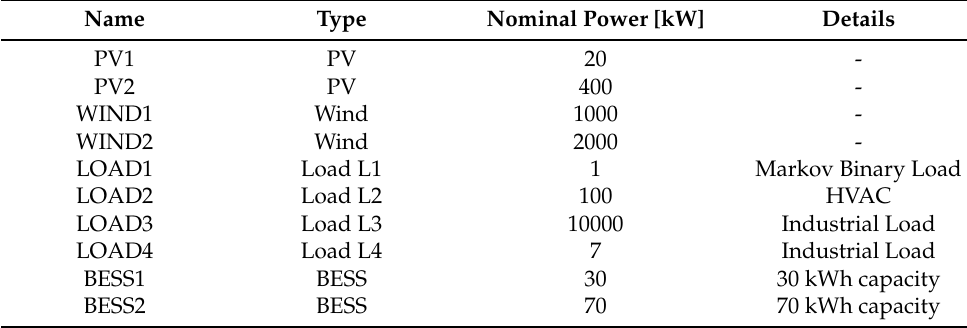
Table 3. Specific plants included in the case studies of this